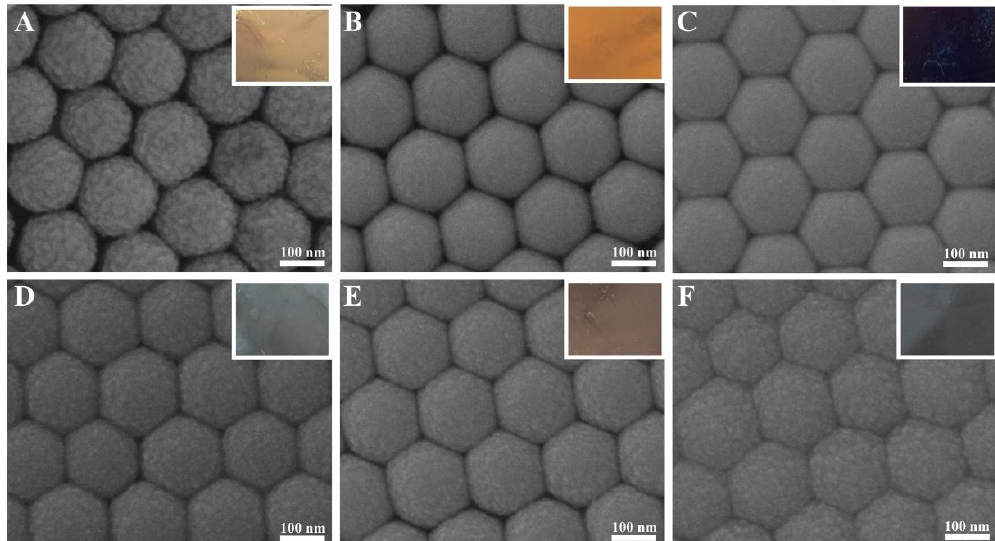
Figure 2. Scanning electron microscope (SEM) images of the Ag 10 nm/TiS 2 (t nm) nanostructures on PS. ( A ) 2, ( B ) 5, ( C ) 10, ( D ) 20, ( E ) 30, and ( F ) 60 nm. The insets are the corresponding optical photos.